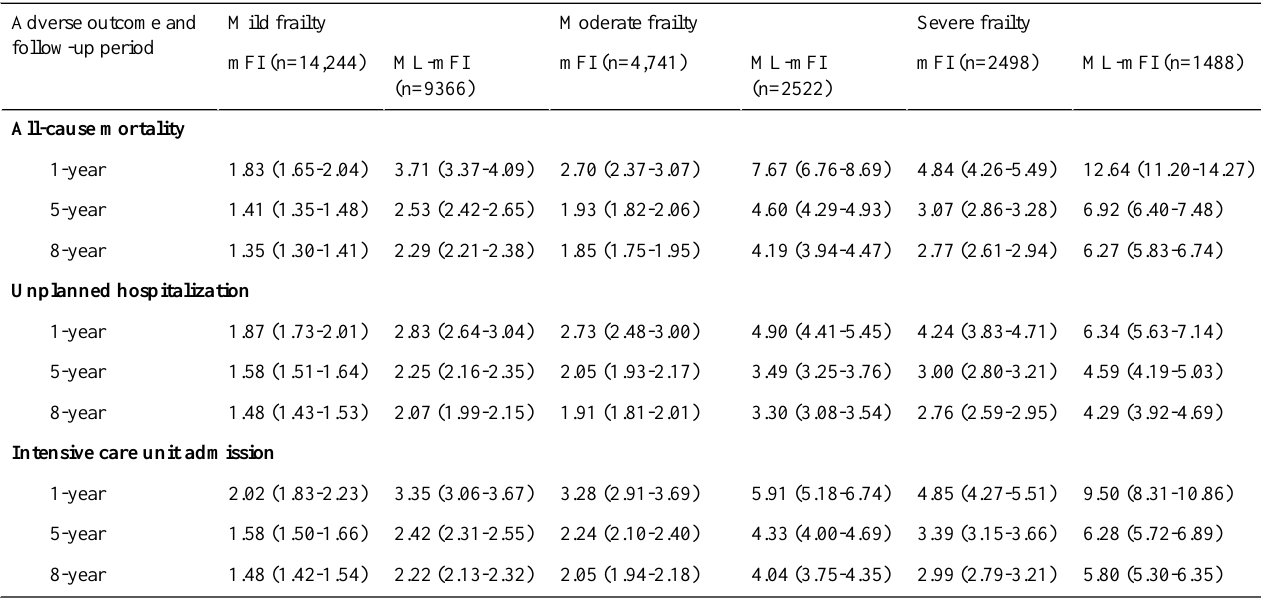
Severe frailtyModerate frailtyMild frailtyAdverse outcome and